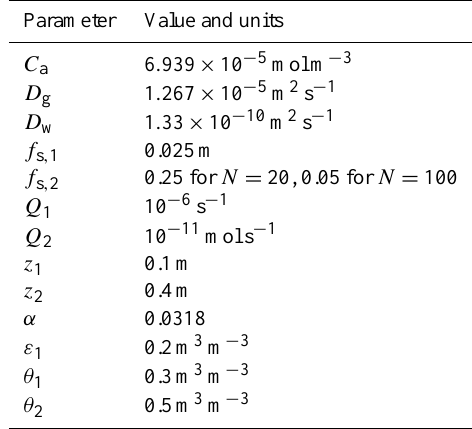
Table 3. Parameters used for the steady-state CH 4